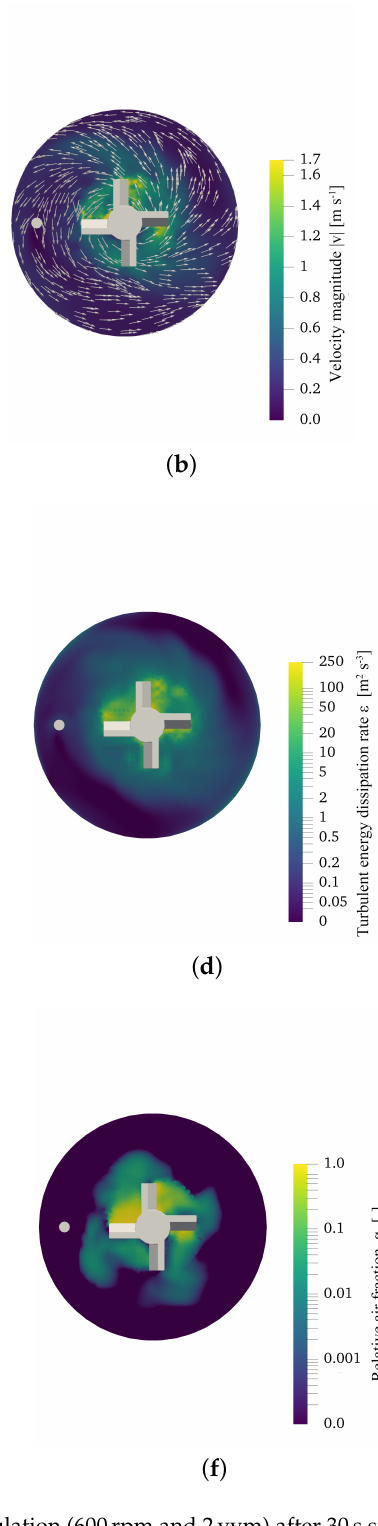
Figure 2. Flow field overview of the base simulation (600rpm and 2vvm) after 30s simulation time. ( a , b ) Velocity field (cid:126) v laterally and from above on the stirrer plane, respectively. ( c , d ) Logarithmic representation of the turbulent energy dissipation rate ε in the same planes, and ( e , f ) relative air fraction α in the bioreactor